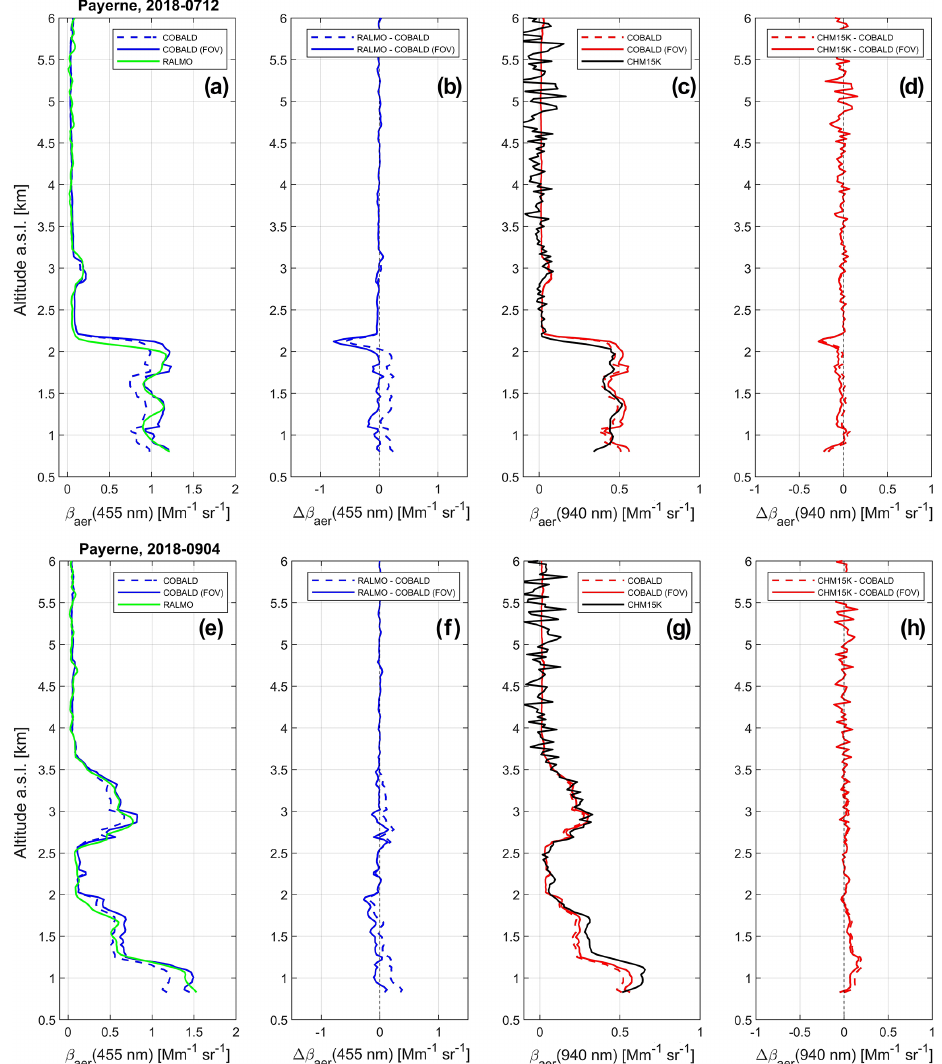
Figure 4. Quantitative comparison of RALMO vs. COBALD (a–b, e–f) and CHM15K vs. COBALD (c–d, g–h) for the selected profiles measured on 7 July 2018 (a–d) and 4 September 2018 (e–h) . Panels (a, e) : vertical profiles of aerosol backscatter coefficient ( β aer ) at 455nm measured by RALMO (green) and COBALD (blue), both without (dashed) and with (solid) application of the FOV correction. Panels (b, f) : vertical profiles of the RALMO − COBALD difference in β aer ( (cid:49)β aer ) at 455nm, both without (dashed) and with (solid) application of the FOV correction. Panels (c, g) : vertical profiles of β aer at 940nm measured by CHM15K (black) and COBALD (red), both without (dashed) and with (solid) FOV correction. Panels (d, h) : vertical profiles of (cid:49)β aer for CHM15K − COBALD at 940nm, both without (dashed) and with (solid) FOV